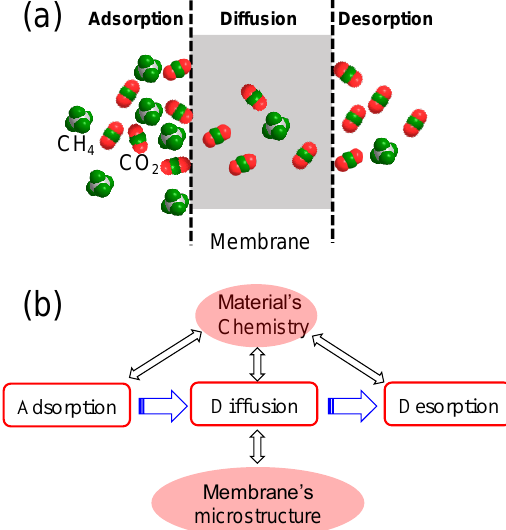
Figure 4. Schemes of ( a ) CO 2 separation through a membrane and ( b ) the factors impacting CO 2 transport behaviors including adsorption on the membrane surface, diffusion across the membrane thickness, and desorption from the membrane permeate surface.